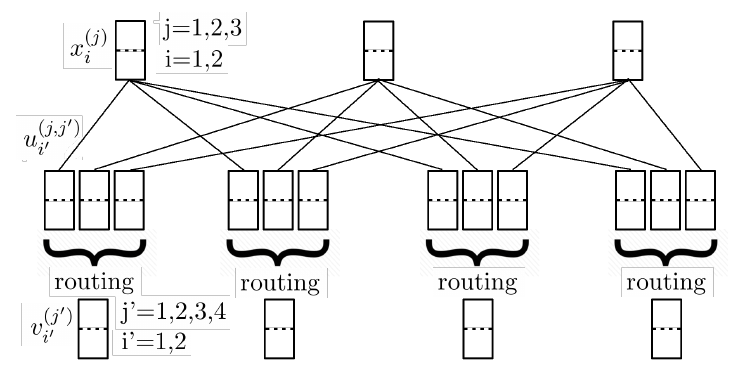
Figure 1: Sketch of a CapsNet module with two simple capsule